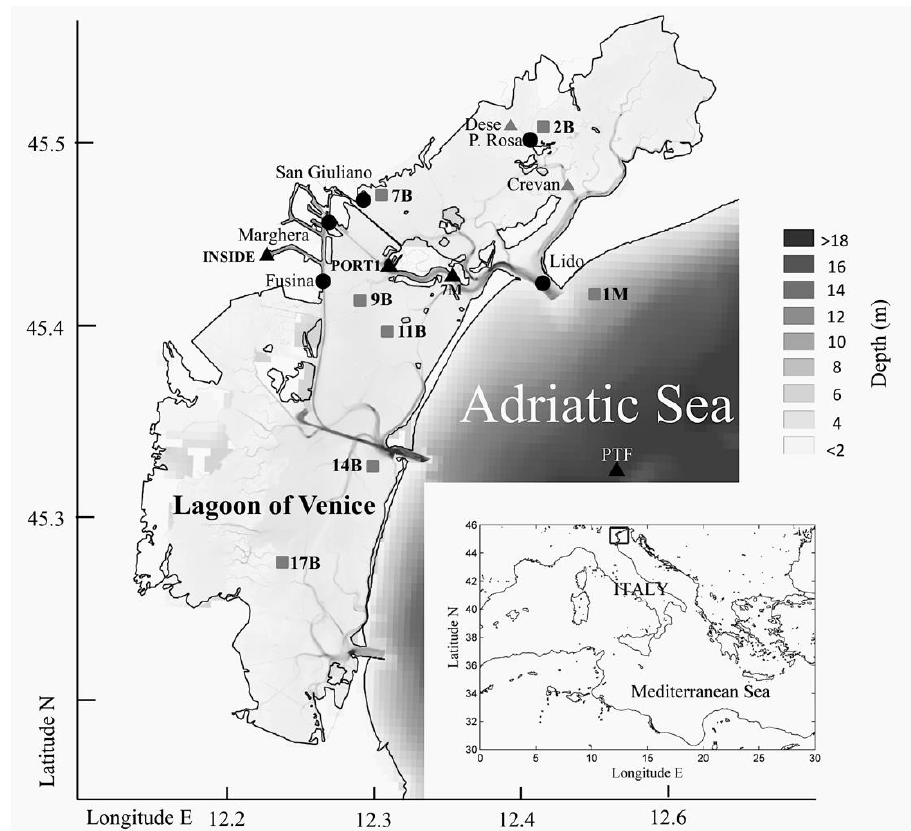
Figure 1. Study area (Lagoon of Venice, Italy) and location of sampling stations during 1975–1980 (grey triangles, including Lido), 1997–2002 (black circles), 2003–2004 (grey squares), and 2014–2017 (black triangles, including San Giuliano, Marghera, Fusina, and Lido).